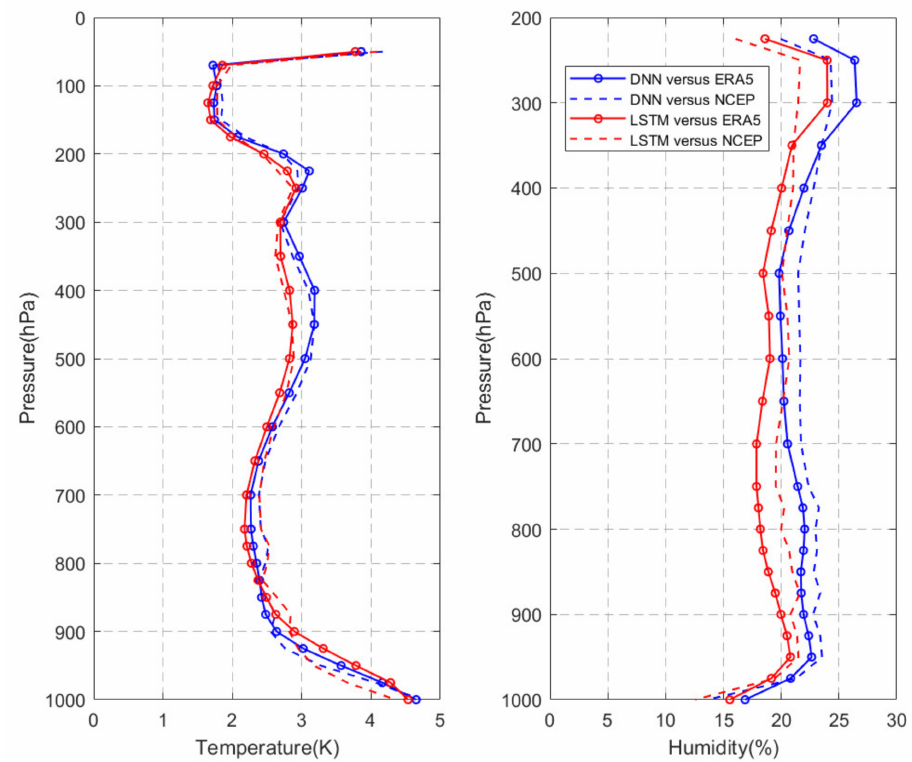
Figure A7. The retrieval RMSEs of the DNN model and the LSTM model with respect to ERA5 and NCEP reanalysis data over mixed surface in April 2021.